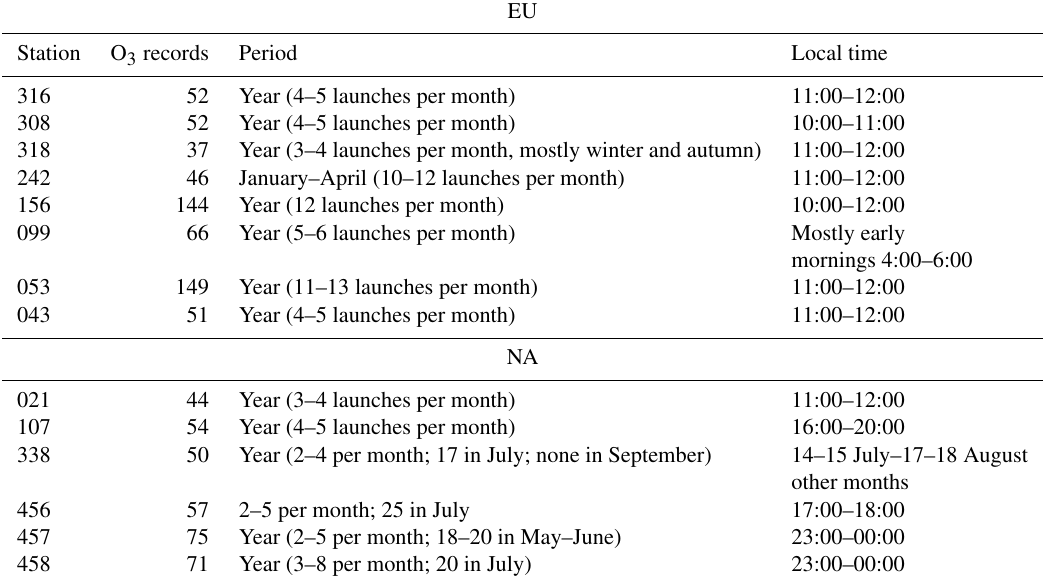
Table 4. Summary of ozonesonde data for